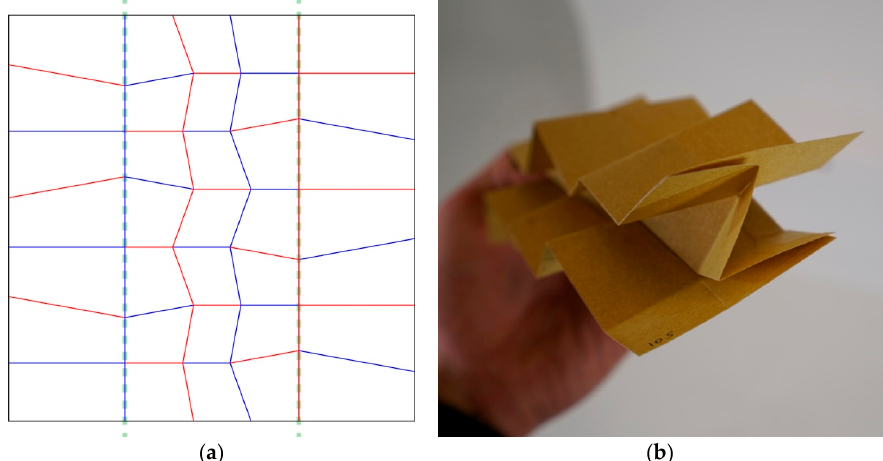
Figure 6. The folding pattern (#105b) presented in ( a ) was made from mirroring the last row of creases on both vertical edges of the #104 pattern, along the green dashed lines and extending them. The mountains and valleys were then inverted for these duplicated sections. This inversion unlocked the folding process, so that this pattern can be fully folded. ( b ) Presents the half-folded state of this new iteration (#105b).